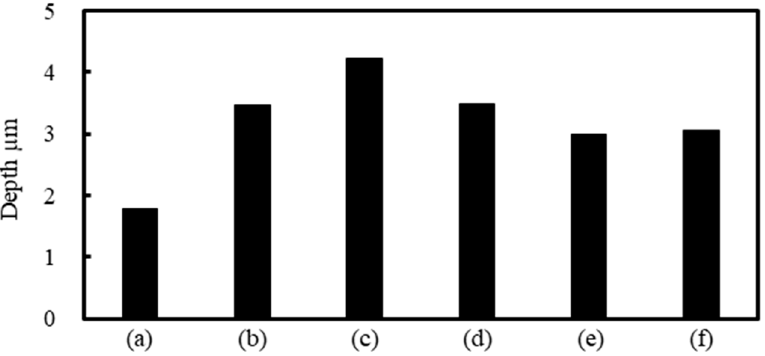
Figure 11. Relationship between the depth of craters and laser irradiation conditions with N = 500 pulses at F = 0.04 J/cm 2 under ( a ) air, ( b ) water, ( c ) 5 wt% NaCl solution, ( d ) 5 wt% NaNO 3 solution, ( e ) 5 wt% Cu(NO 3 ) 2 solution and ( f ) 5 wt% CuSO 4 solution.